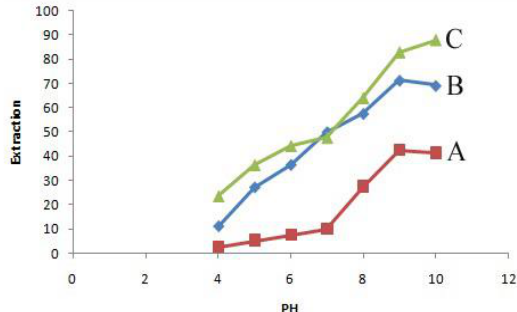
Fig. 6. The pH effect on the adsorption efficiency of phenylalanine: (A) uncoated Fe